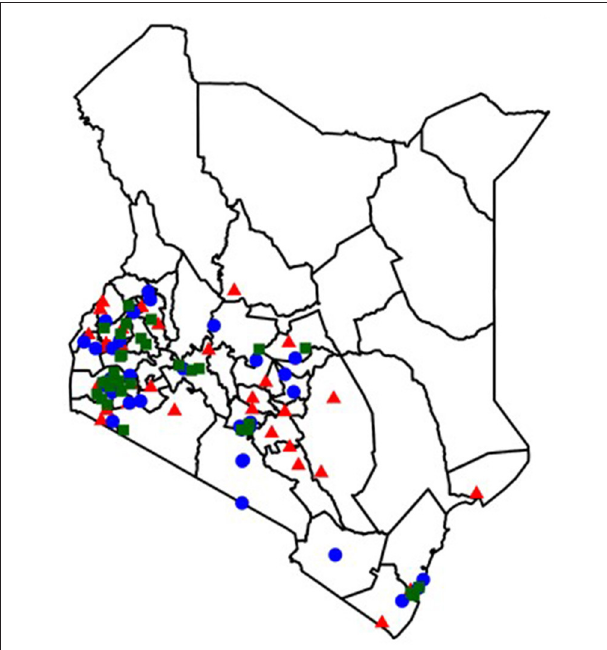
FIGURE 1 | Distribution of facilities included in the facility survey. Facility distribution by estimated clinic size at the time of random selection. Blue Circle, small facilities (300–455 total HIV patients); Red Triangle, medium facilities (456–866 total HIV patients); Green Square, large facilities ( ≥ 867 total HIV